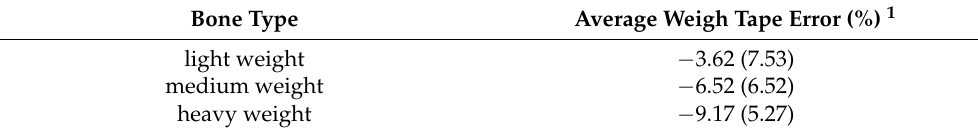
Table 3. Average weigh tape error for each bone type